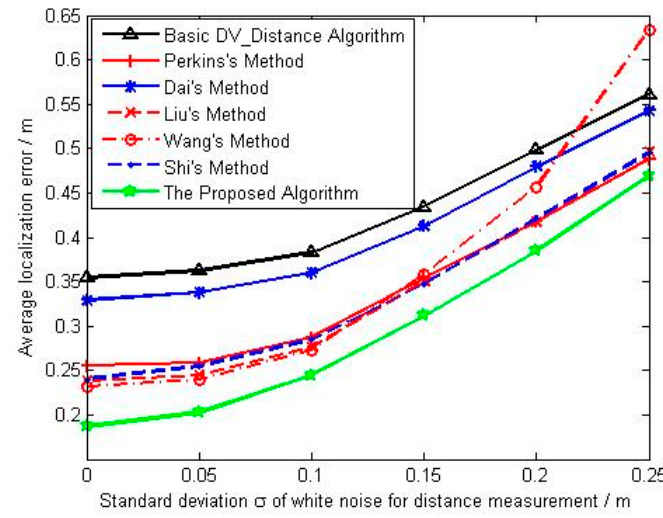
Figure 5. The change curve of average localization error with noise intensity.